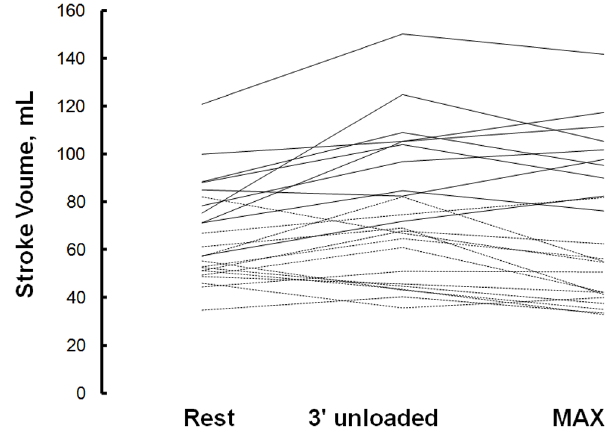
Figure 3. Stroke volume calculated at rest, after 3 minutes of unloaded cycling and directly after the end of maximal CPET in 18 pulmonary hypertension patients (stripped line) and 10 healthy subjects (solid line).